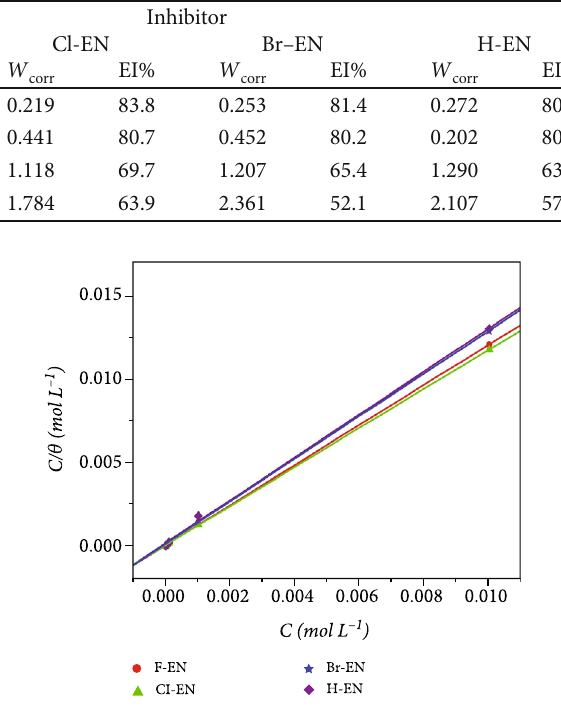
Figure 8: Langmuir adsorption isotherm plot for the inhibitors on carbon steel surface in 1.0molL -1 HCl. Figure 7: Arrhenius graph for AISI 1020 carbon steel in 1.0molL -1 Table 8: Values of parameters obtained from linearized Langmuir HCl solution in the absence and presence of inhibitors. △ H ≠ △ S ≠ Table 7: Values of E a , ads in the corrosion process ads , and of AISI 1020 carbon steel in 1.0molL -1 HCl, in the absence and presence of inhibitors.